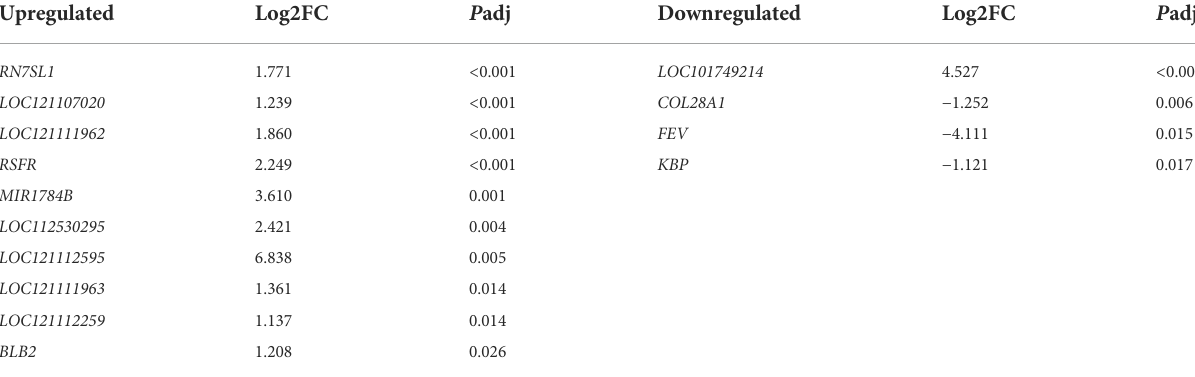
TABLE 4 The top 10 genes in the hypothalamus of the capon group were up- and down-regulated compared to that of rooster group. Upregulated Log2FC P adj Downregulated Log2FC P